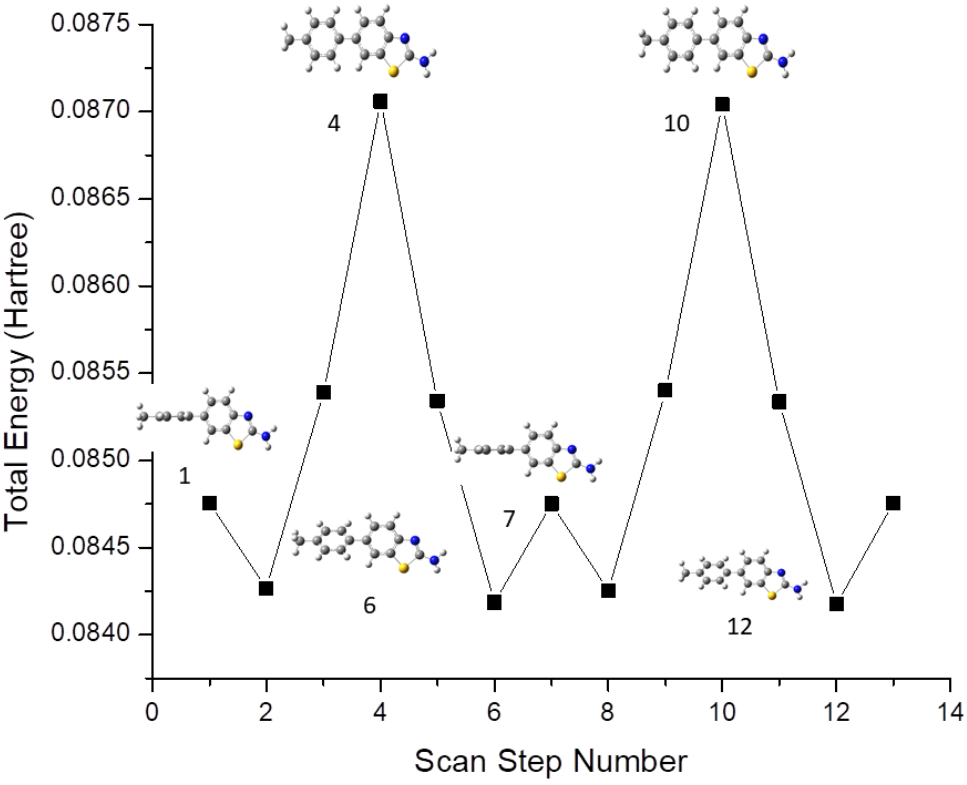
Figure 1. Theoretically calculated conformers of Compound 1 at B3YLP/6-311G(d,p)/SMD 1,4-dioxane level of theory.